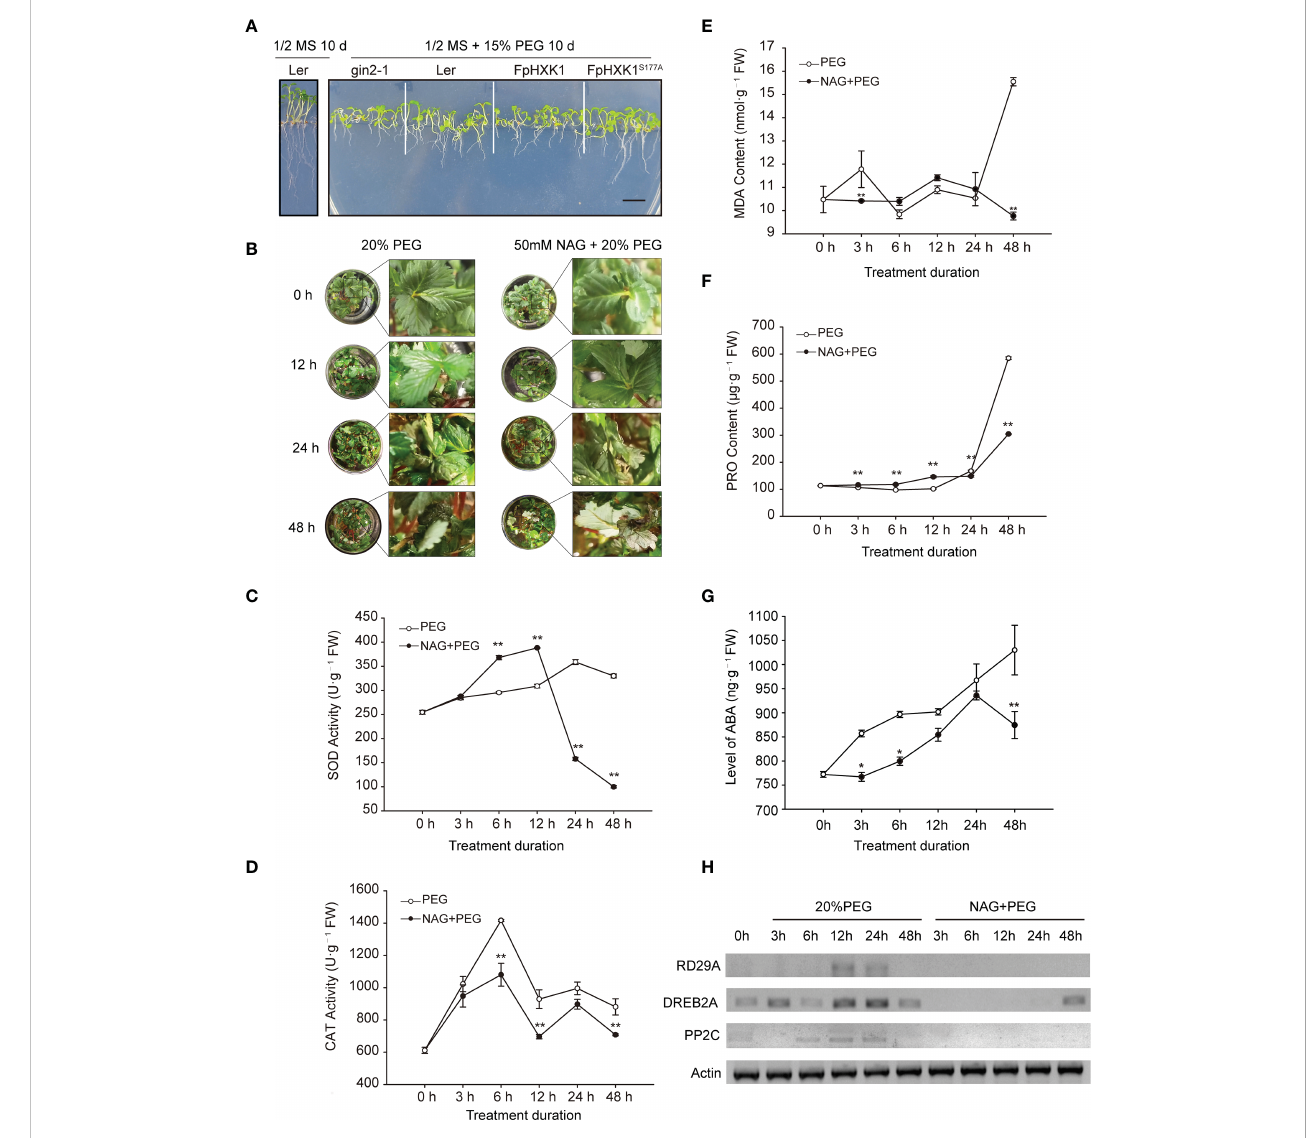
FIGURE 7 The role of strawberry FpHXK1 on drought stress responses in A. thaliana and strawberry plants. (A) WT ( Ler ) and transgenic seedlings germinated on MS medium with 15% PEG-6000 for 10 days. Scale bar, 0.5 cm; (B) Plant phenotype of the strawberry plantlets exposed to 20% PEG-6000 or combination of 50 mM NAG and 20% PEG-6000 for 0, 12, 24, 48 h respectively. (C – G) Altered levels of SOD, CAT, MDA, PRO and ABA in strawberry plants. Vertical bars represent SEM. Asterisks indicate signi fi cant differences between plants in which the HXK activity was inhibited by NAG and in the control plants (* p < 0.05; ** p < 0.01). (H) Transcript levels of drought-induce genes ( RD29A , DREB2A and PP2C ), FpActin was used as a